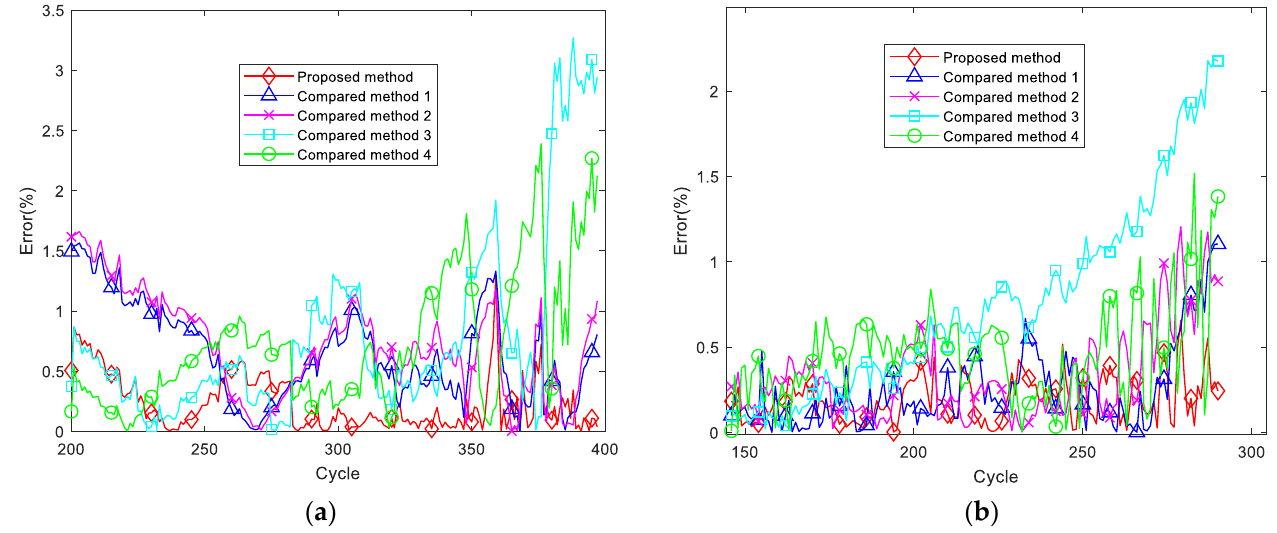
Figure 10. The absolute SOH estimation error values of the comparative experiment. ( a ) Battery pack; ( b ) battery cell. Table 3. The MAE, ME and computational burden of the comparative experiment.